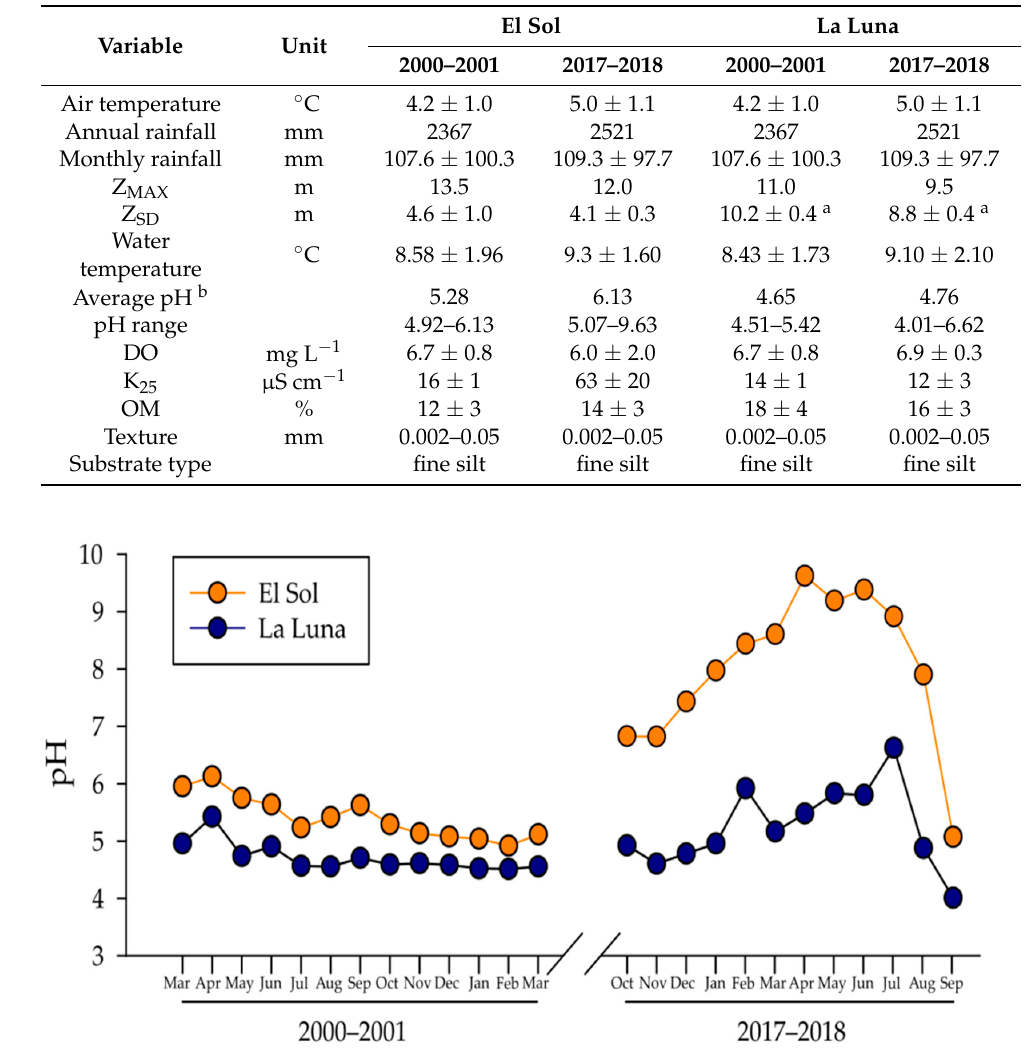
Figure 3. Temporal dynamics of pH in Lakes El Sol (orange dots) and La Luna (blue dots).